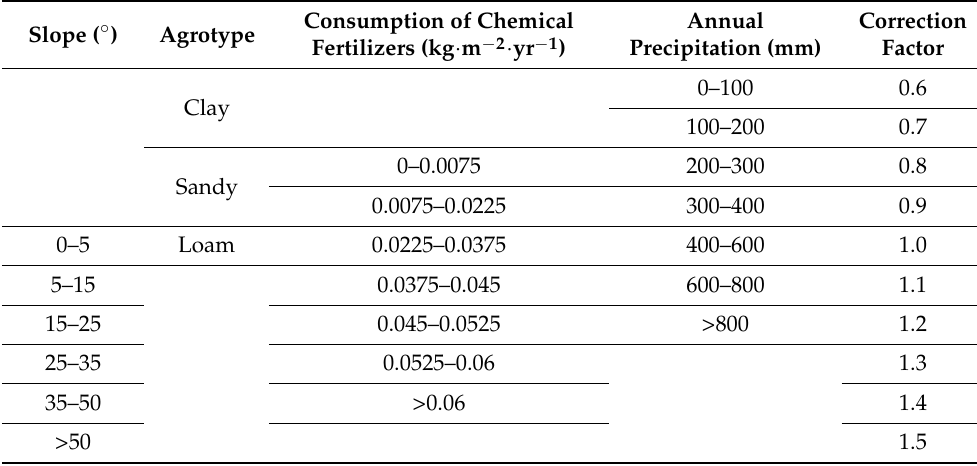
Table 5. Crop growth environmental correction coefficient